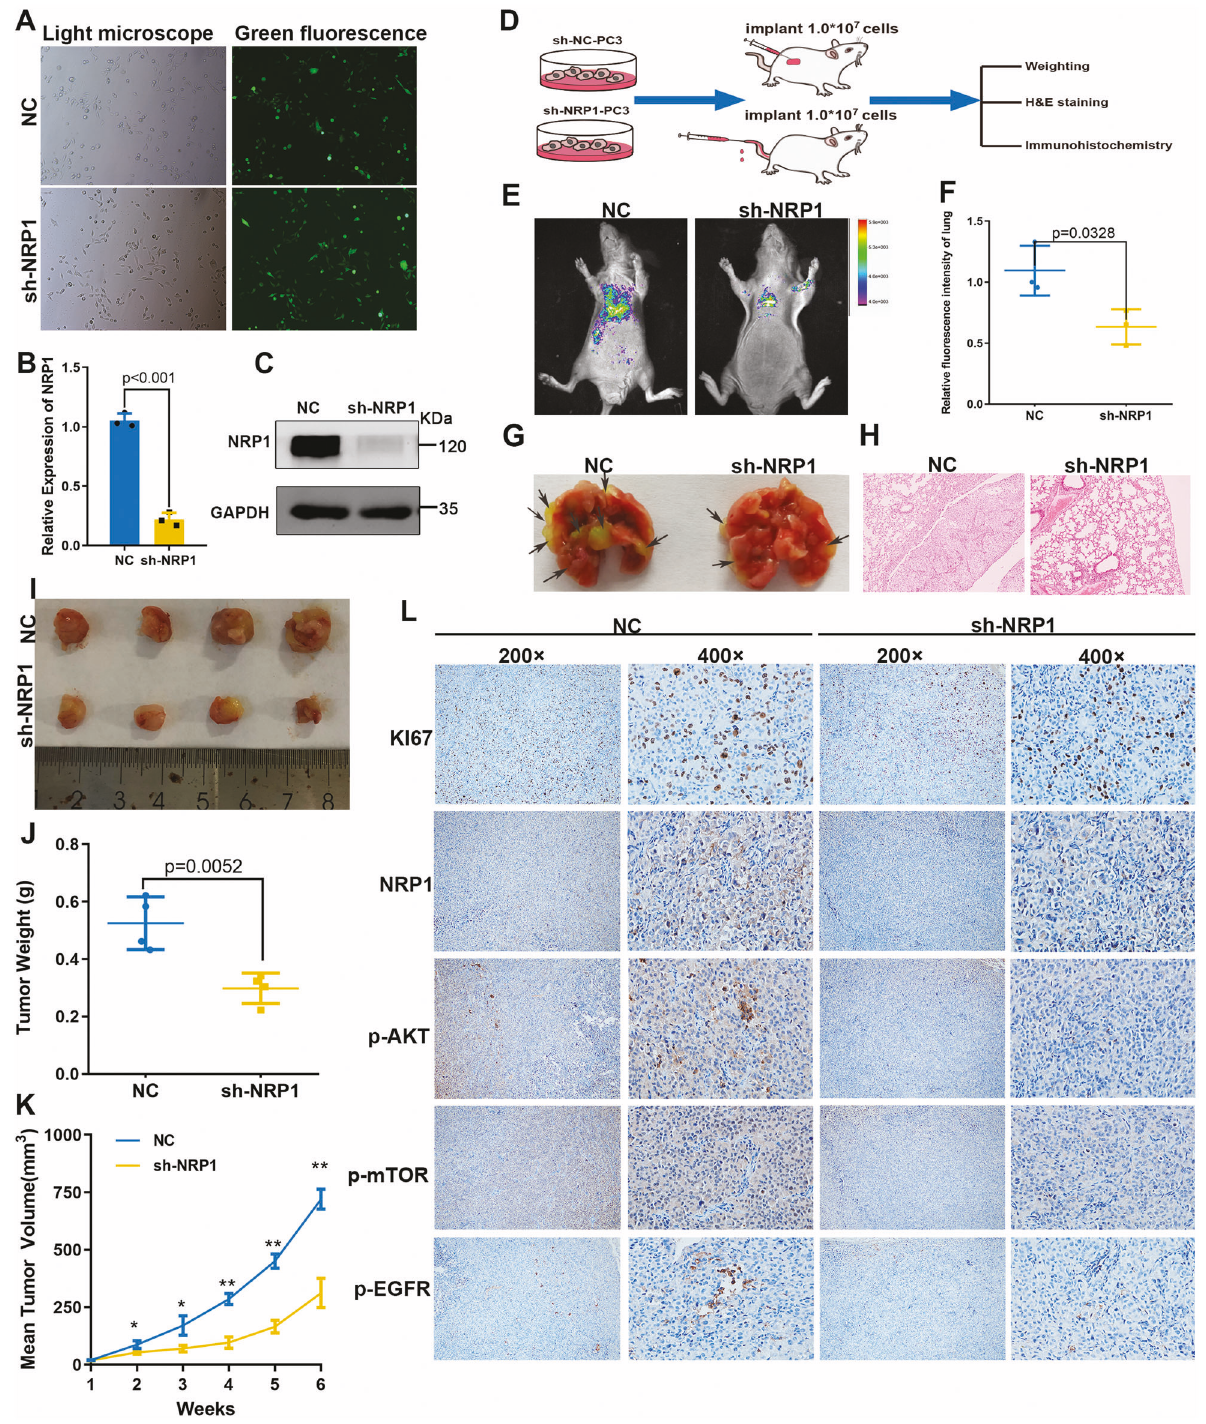
Fig. 4 NRP1 promotes PCa cell proliferation and migration in vivo. A Green fl uorescence of PC-3 stable cells. B , C qRT-PCR and immunoblot assay verify NRP1-depletion ef fi ciency in PC-3 stable cells. D Xenograft mice models and pulmonary metastasis models were established by subcutaneously injecting LV-NC cells or LV-sh-NRP1 cells. Mice were monitored continuously for 5 weeks in xenograft mice models and 8 weeks in the pulmonary metastasis model. Then the mice were sacri fi ced and the tumors were dissected. E Fluorescence intensity of pulmonary metastasis is detected by imaging apparatus for small animals in vivo, F sh-NRP1 group ( n = 3) signi fi cantly inhibited lung metastasis of PCa cells compared with that in the NC group ( n = 3). G Lung tissue specimens show pulmonary metastatic nodules, where the arrows denote the tumors transferred to the lungs. H H&E staining of lung tissues (scale bar = 100 μ m). Statistical analysis of tumor volume and weight in two groups ( n = 4 in each group). I Tumor image of xenograft mice models. J NRP1 depletion signi fi cantly decreases the weight of the tumor xenograft. K NRP1 depletion signi fi cantly inhibits tumor growth. L IHC staining detects the expression of Ki67, NRP1, p-AKT, p- mTOR, and p-EGFR. Data are shown as the mean ± SD. Statistical signi fi cance was assessed using a two-tailed t test. * P < 0.01, ** P < 0.001.